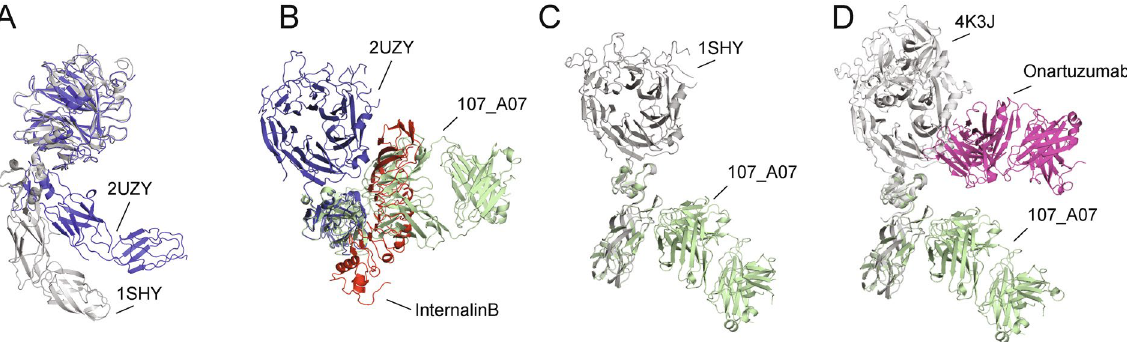
Figure 6. Comparison of the 107_A07 Fab with compact (InlB-bound) and extended (HGF/SF β -bound) structures of the MET ectodomain. ( A ) The compact (blue) and extended (grey) conformations of extracellular MET (amino acids 25–741). The structure of compact MET is from PDB accession 2UZY (chain B), (complex of MET with InlB); the structure of MET in extended conformation is from PDB accession code 1SHY (HGF/ SF beta chain in complex with SEMA domain of MET). ( B ) Superposition of the MET-107_A07 Fab complex (shown in green) with MET in compact conformation (2UZY), obtained by superposing the CR domains. The MET CRD-Ig1-Ig2 domains are oriented perpendicular to the image. The InternalinB structure is shown in red. ( C ) Superposition with MET in extended conformation (1SHY). The position of Ig1-Ig2 was obtained as described in ( B ). ( D ) Superposition with MET in extended conformation (4K3J, complex of MET and the Fab fragment of onartuzumab). The onartuzumab structure is shown in